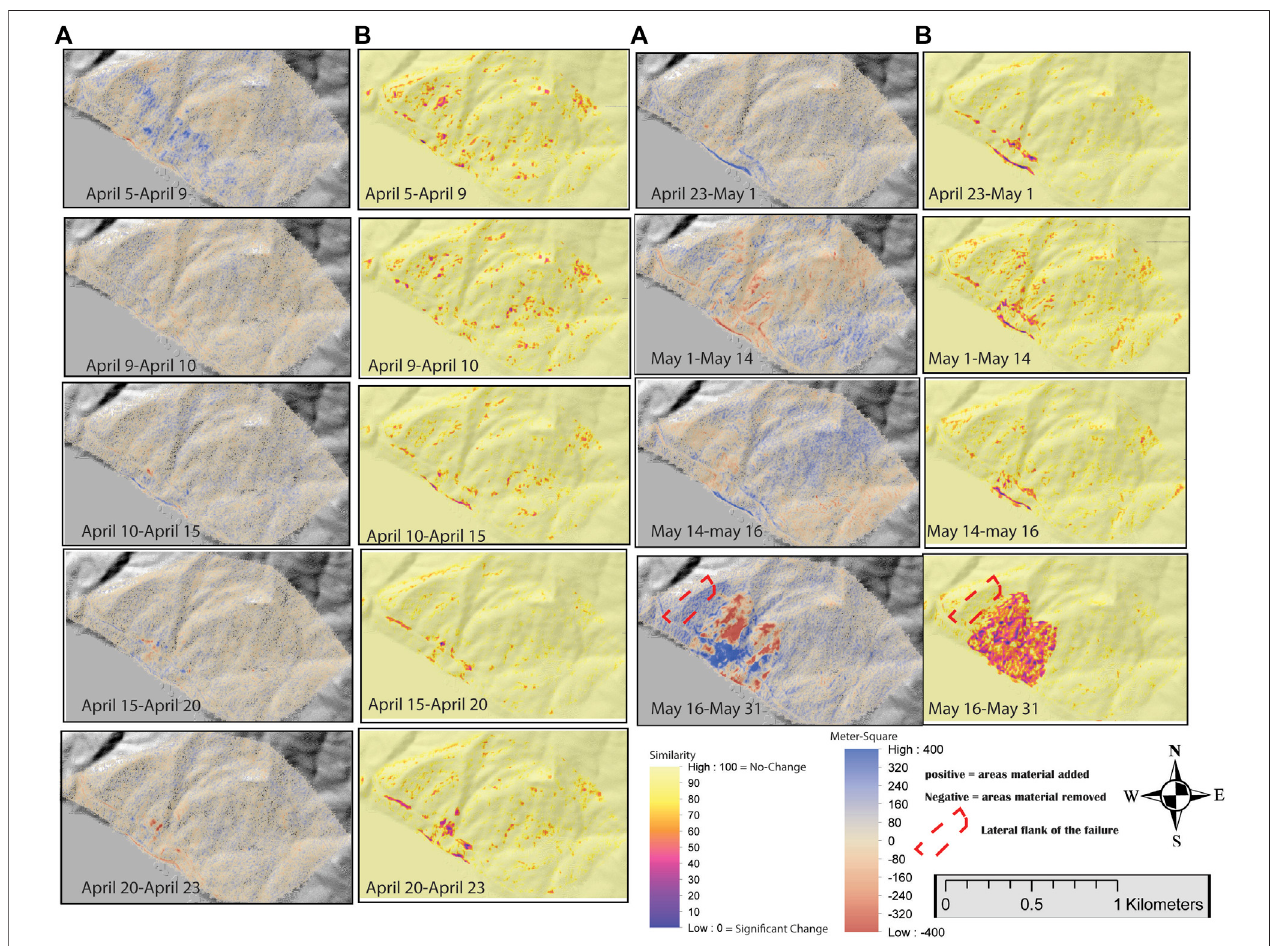
FIGURE4| StaticchangedetectiontimestampresultsfortheMudCreeklandslide.Column (A) showstheimagedifferencingresults;negativevaluesindicateareas withmaterial being removed, andpositivevaluesindicate areawithmaterial being added. (B) showstheStructuralSimilarity Index Map, similarity mapscaled between0 = no similarity and 100 = strongly similar (no